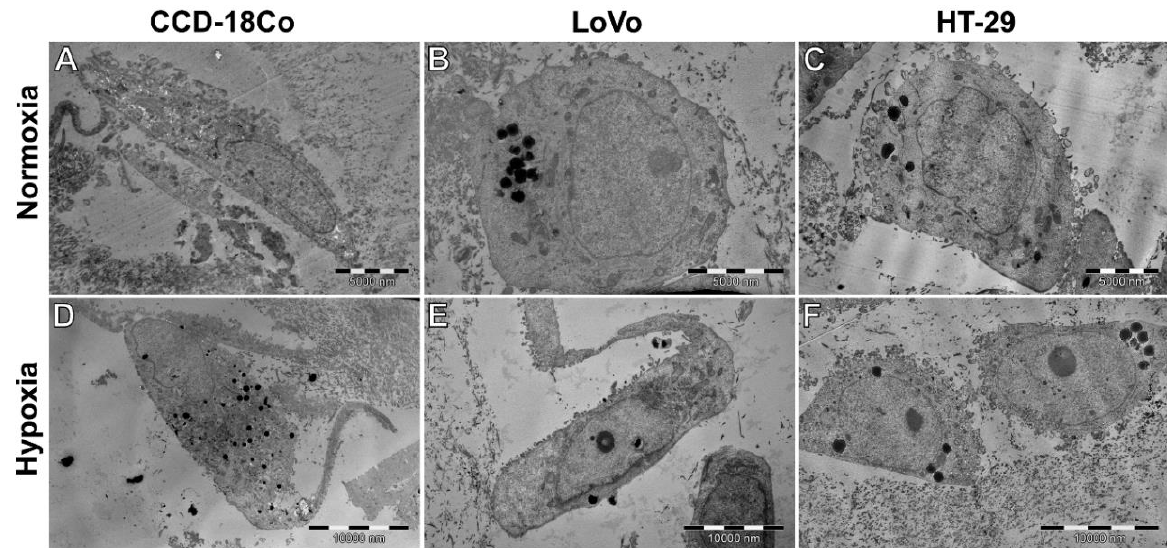
Figure 7. A comparison of cell morphology in normoxia ( A – C ) and hypoxia ( D – F ) in examined cell lines. No major differences were visible, besides elongated protrusions in hypoxic CCD-18Co cells ( D ). Regardless of oxygenation, cells tend to exhibit visible exocytic activity; they maintain similar shape and morphology of nuclei.